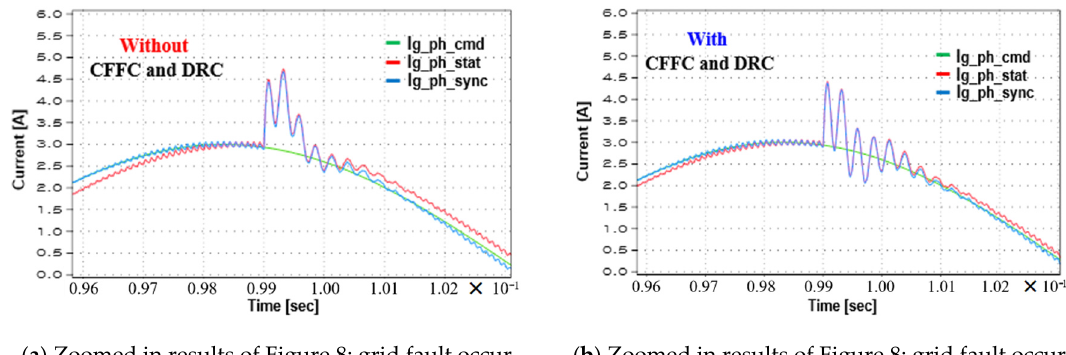
( a ) Zoomed in results of Figure 8: grid fault occur ( b ) Zoomed in results of Figure 8: grid fault occur Figure 9. Simulation results of the output currents ( a ) without and ( b ) with the CFFC and DRC.